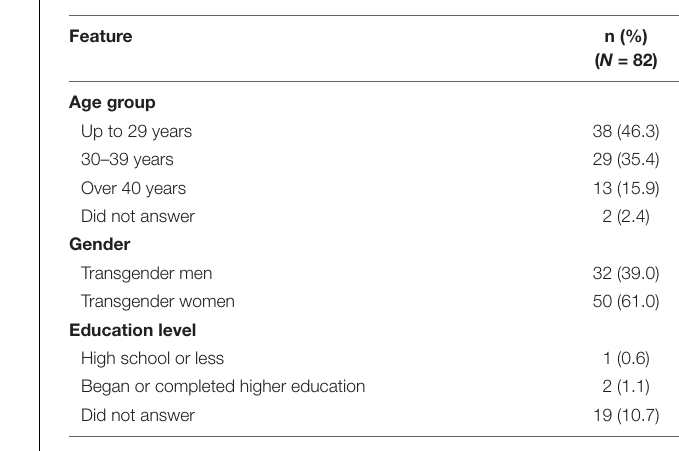
TABLE 1 | Sociodemographic characterization of the